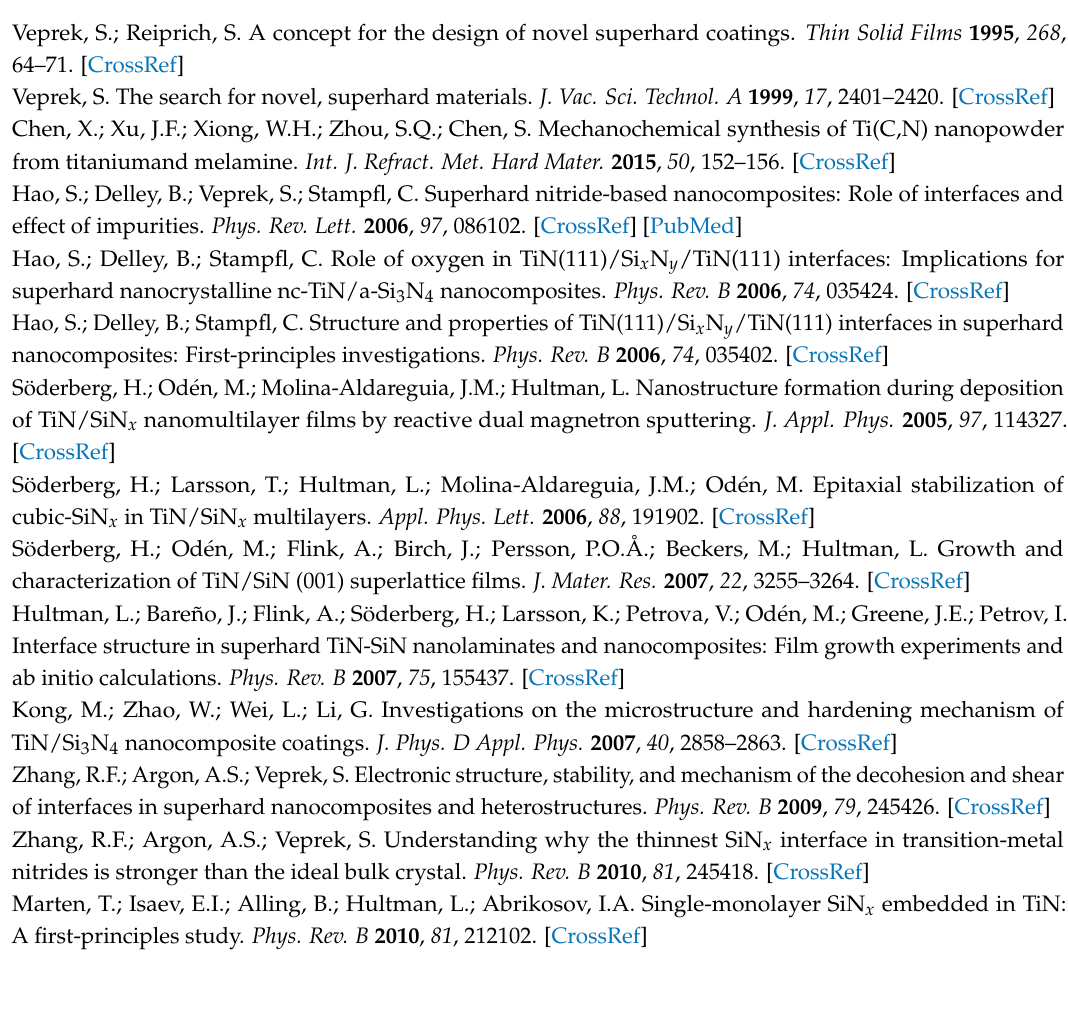
Figure S1: Band structure, density of state (DOS) and partial density of state (PDOS) of B1–NaCl structure of TiN; Figure S2: Band structure, density of state (DOS) and partial density of state (PDOS) of B1–NaCl structure of B1-SiN; Figure S3: Band structure, density of state (DOS) and partial density of state (PDOS) of